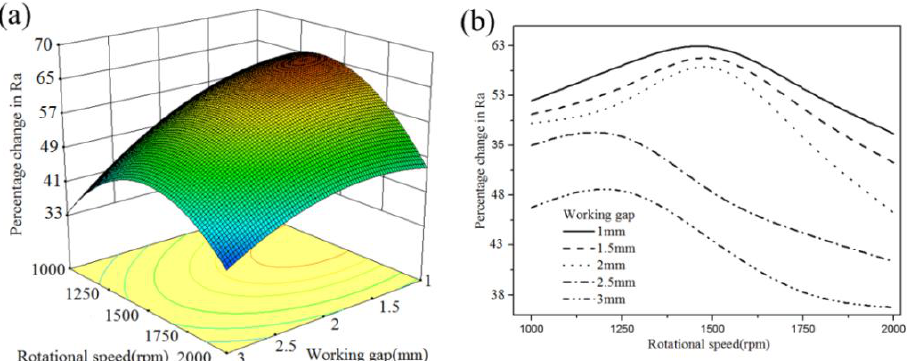
Figure 9. Interaction effect between the working gap and rotational speed (feed rate: 1 mm/min; mesh no.150): ( a ) 3D curved surface; ( b ) 2D graph. mesh no.150): ( a ) 3D curved surface; ( b ) 2D graph.